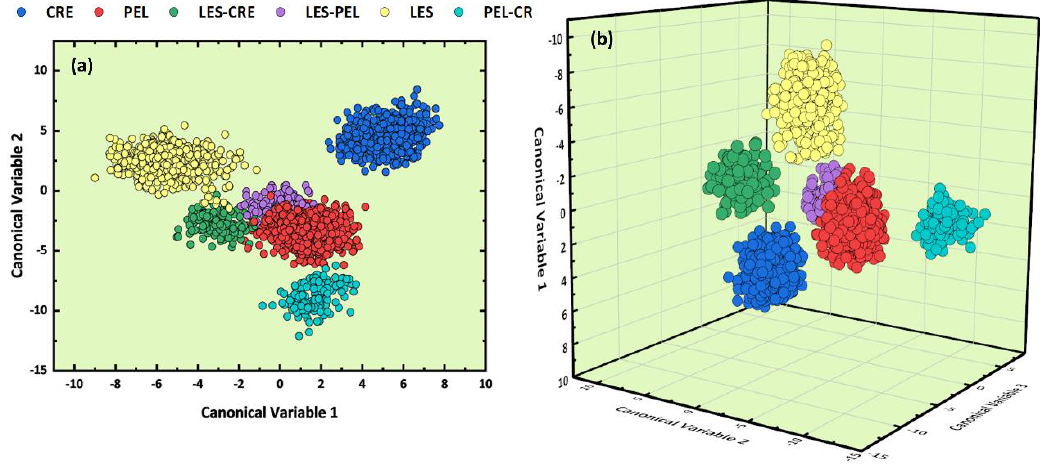
Figure 6. 2D ( a ) and 3D ( b ) LDA plots obtained using the olive oils’ absorption Figure 6. 2D (a) and 3D (b) LDA plots obtained using the olive oils’ absorption spectra.